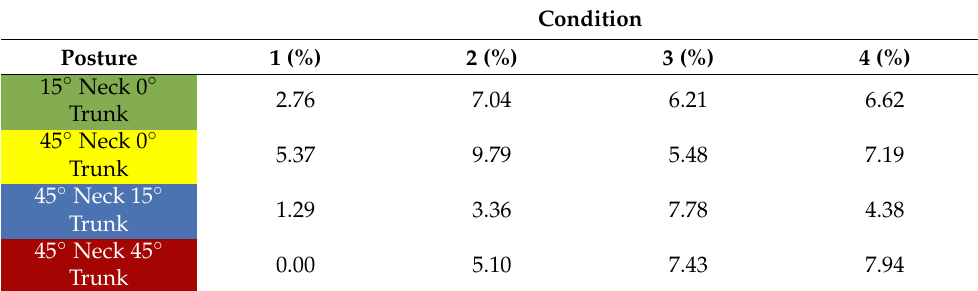
Table 1. Percentage difference between mean STHT pre- and post-condition in four rotated neck and trunk postures. Condition Posture 1 (%) 2 (%) 3 (%) 4